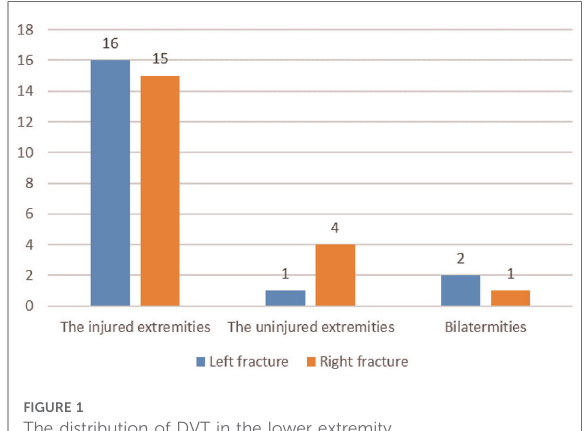
FIGURE 1 The distribution of DVT in the lower